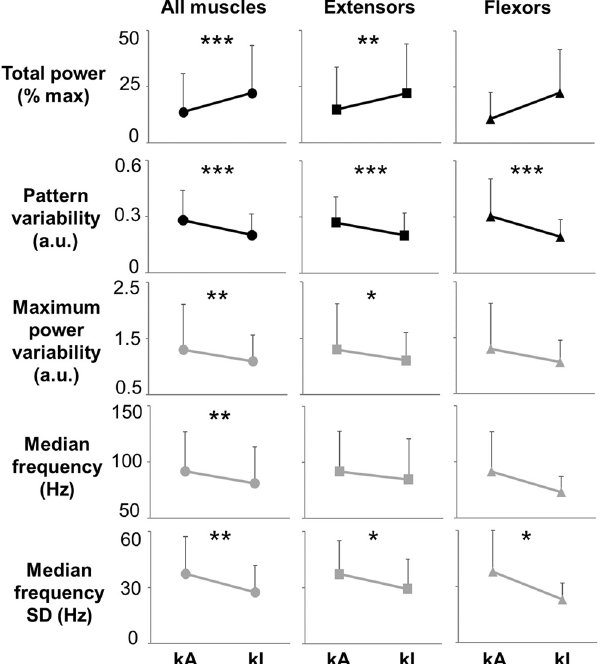
Figure 6. Quantification of EMG-time and –frequency domain features collected during standing with one lower limb assisted for knee extension. Representative time- and frequency-domain EMG features collected during standing when one lower limb achieved independent extension (kI) while the contralateral limb required external assistance for knee extension (kA). EMG features values were averaged among research participants (n = 7) and among different muscle groups of the assisted lower limb (kA) or the independent lower limb (kI). In particular, all investigated muscles (soleus, medial gastrocnemius, vastus lateralis, rectus femoris, gluteus maximus, tibialis anterior and medial hamstring; total n = 49), primary extensor muscles (left and right soleus, medial gastrocnemius, vastus lateralis, rectus femoris, gluteus maximus; total n = 35), or primary flexor muscles (left and right tibialis anterior and medial hamstring; total n = 20) were considered for analysis. Values are expressed as mean ± standard deviation (SD). Differences were tested by Wilcoxon test. * p < 0.05; ** p < 0.01; *** p <